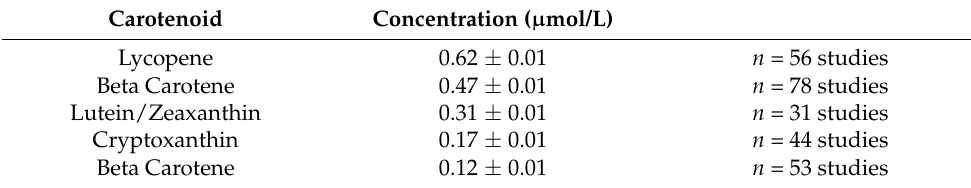
Table 2. Carotenoid composition of human skin in ng/g tissue (Reprinted with permission from Ref [33]. 2022, SPIE).